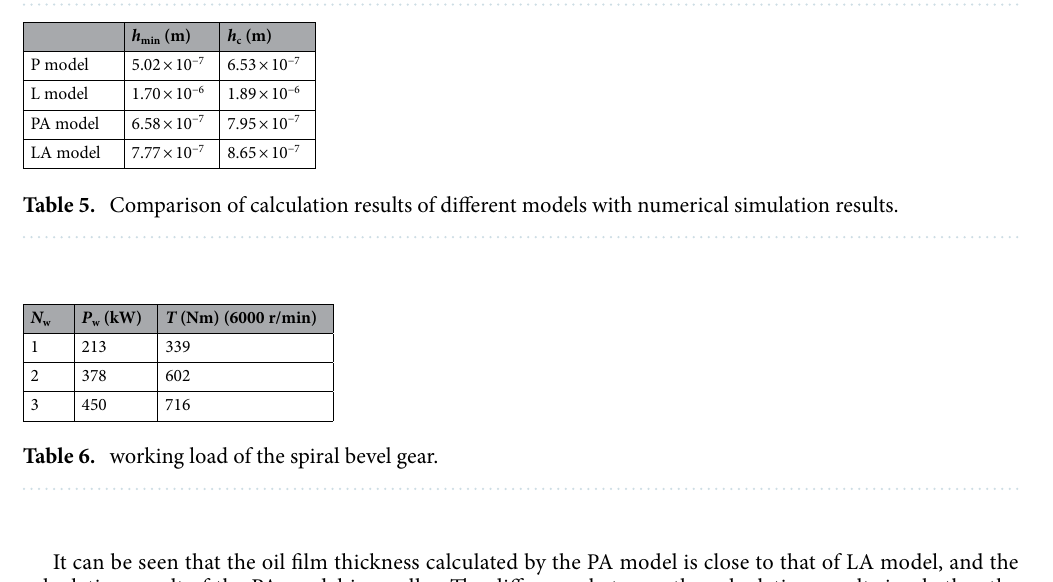
Figure 7. Central oil film thickness and minimum oil film thickness for different calculation models.